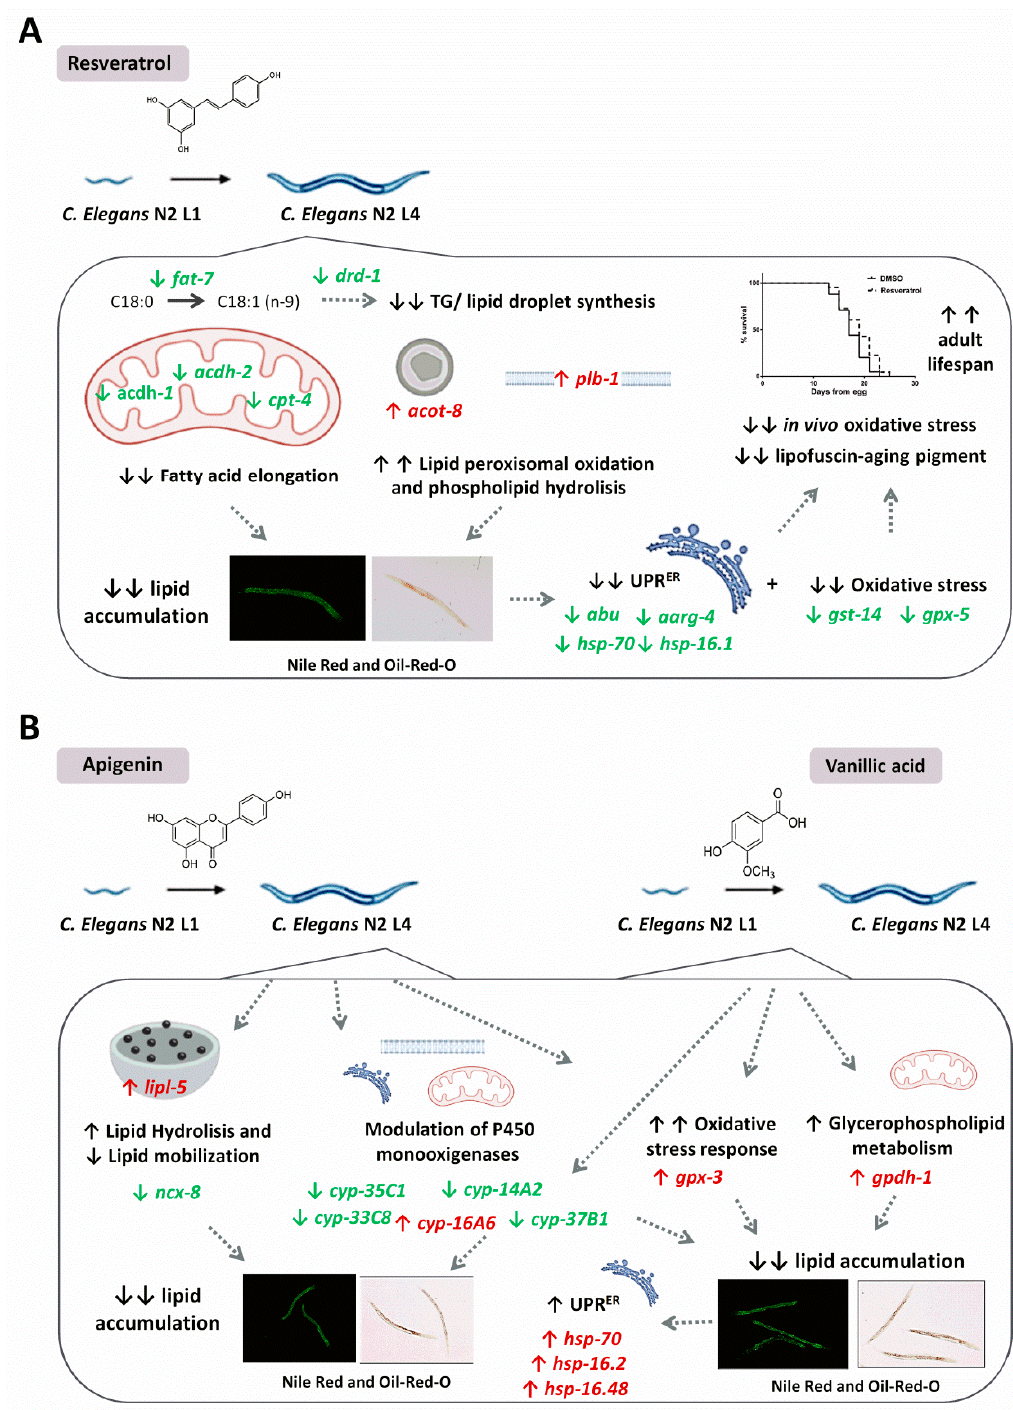
Figure 6. ( A ) C. elegans treatment with resveratrol during the L1 to L4 stages mimics the calorie restriction response, as suggested by the reduced expression of the lipid synthesis-related genes fat-7 and drd-1 , together with a reduced lipid mobilization and elevated peroxisome lipid oxidation and hydrolysis, which explains the reduced fat content of the treated worms. As a result, endoplasmic reticulum-UPR and glutathione metabolism stress responses are downregulated, which might be responsible for the improvement of C. elegans health and lifespan by this phenolic compound. ( B ) C. elegans treatment with apigenin induced a significant upregulation of the triglyceride lipase gene lipl-5 , together with